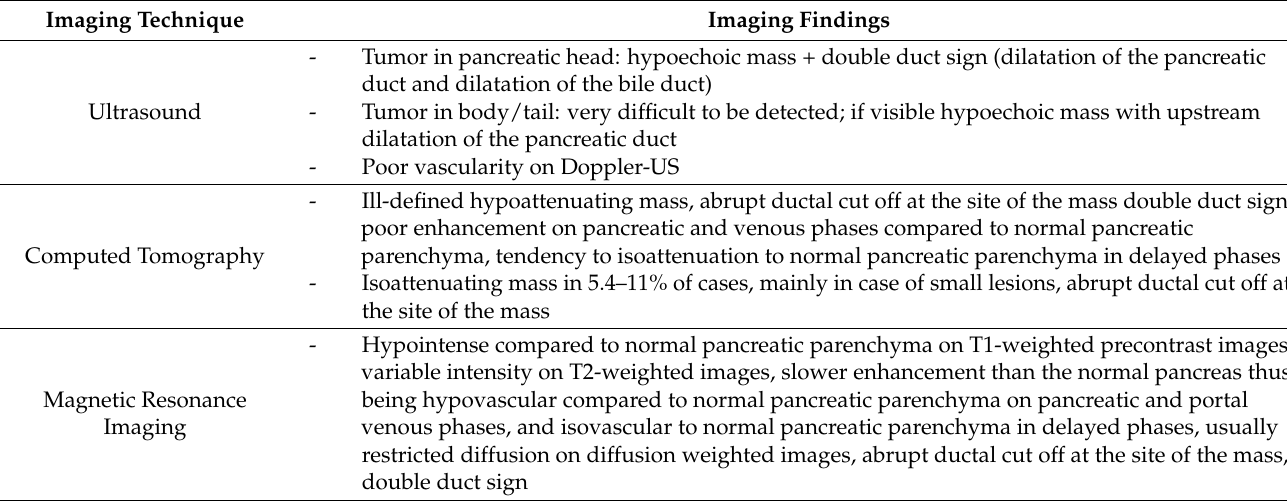
Table 1. Main imaging findings of PDAC on ultrasound, CT, and